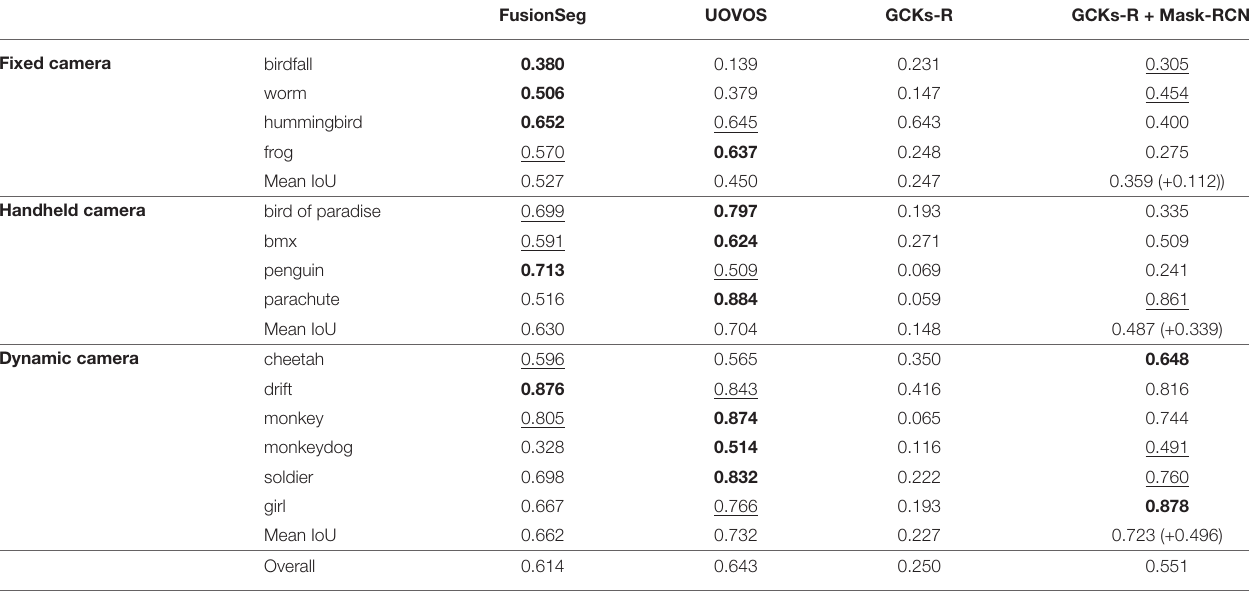
TABLE 3 | Comparison with alternative approaches that also combine motion information with appearance